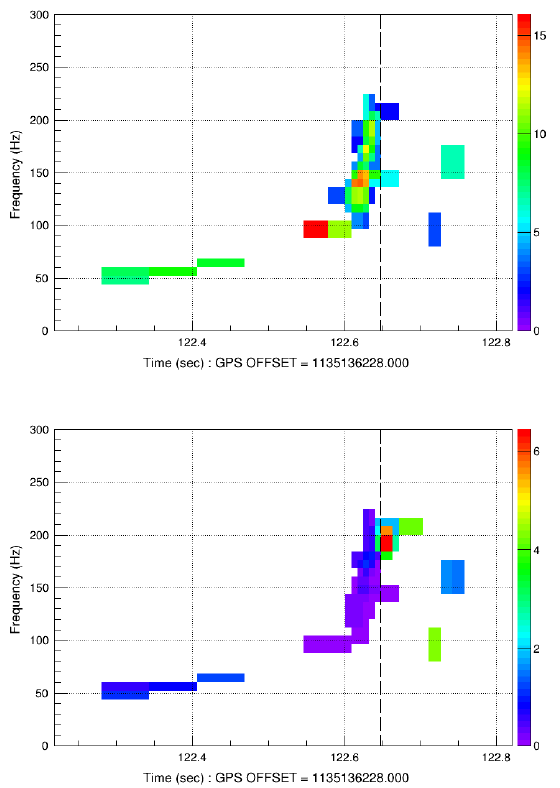
Figure 33. Reconstruction of cWB for the event GW151226, as color-coded time-frequency maps [25]. The upper plot shows the squared coherent network SNR and the plot bellow shows the normalized FIG. 5. cWB waveform reconstruction of GW151226, in form of color-coded time-frequency maps. The upper row shows residual noise energy. The residual plot is given after the reconstructed signal was subtracted from the data. In this plots a secondary cluster occurring 100 ms after the merger (consistent with echo times the square coherent network SNR, while the second row shows the normalized residual noise energy, E predicted and seen by ADA, Equation (144)). The dashed vertical lines denote coalescence time for reconstructed signal is subtracted from the data. The first column ((a) and (d)) refers to the original reconstruction, with the GW151226 (the network has used the Livingston detector time as a reference). primary chirp on the left matching the CBC PE reconstruction and a secondary cluster occurring 100 ms after the merger. An ad hoc time veto covering the secondary cluster was used to produce our best estimate for GW151226 primary event shown in the second column ((b) and (e)). Finally, the third column reports the independent reconstruction of the secondary cluster by vetoing the primary event. The dashed vertical lines show the minR t the Livingston detector time as a reference).